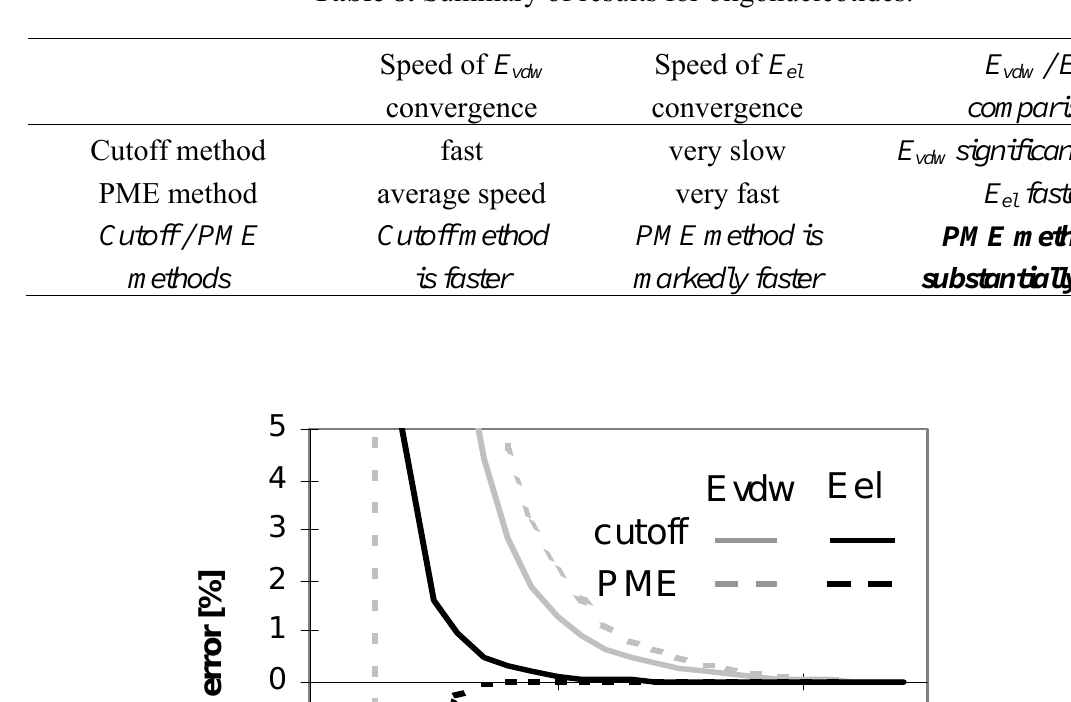
Table 8. Summary of results for oligonucleotides.